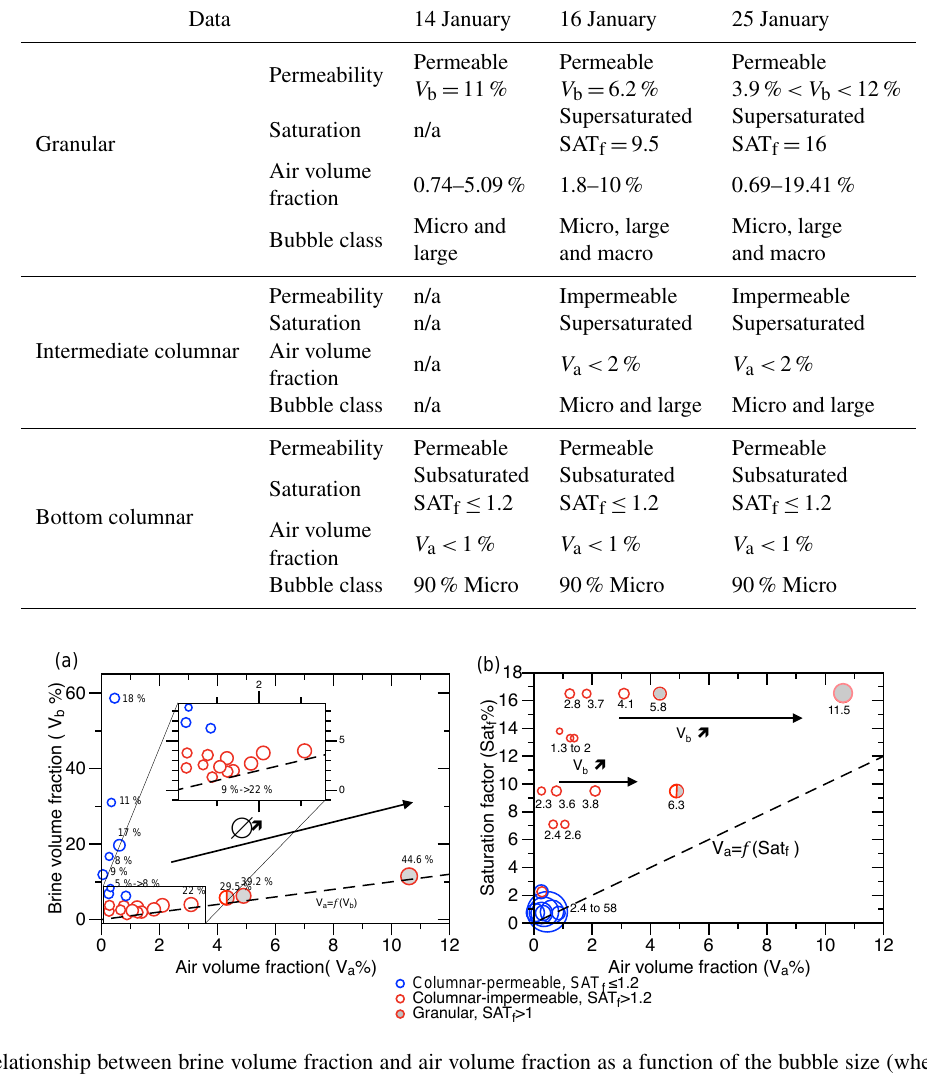
Figure 13. (a) Relationship between brine volume fraction and air volume fraction as a function of the bubble size (where the size of each marker circle is proportional to the percentage of bubbles with diameters > 1mm, written as % value next to some of circles). (b) Relationship between the air volume fraction and the saturation factor as a function of the brine volume fraction. The size of each circle denotes the brine volume fraction (%, written next to some of the circles). In each panel, the bottom columnar permeable subsaturated ice (SAT f ≤ 1.2, blue cir- cles) is differentiated from the columnar impermeable supersaturated ice (SAT f > 1.2 , red circles), and from the top granular supersaturated ice (SAT f > 1.2 , grey circles). In each panel, the dotted line signifies the 1:1